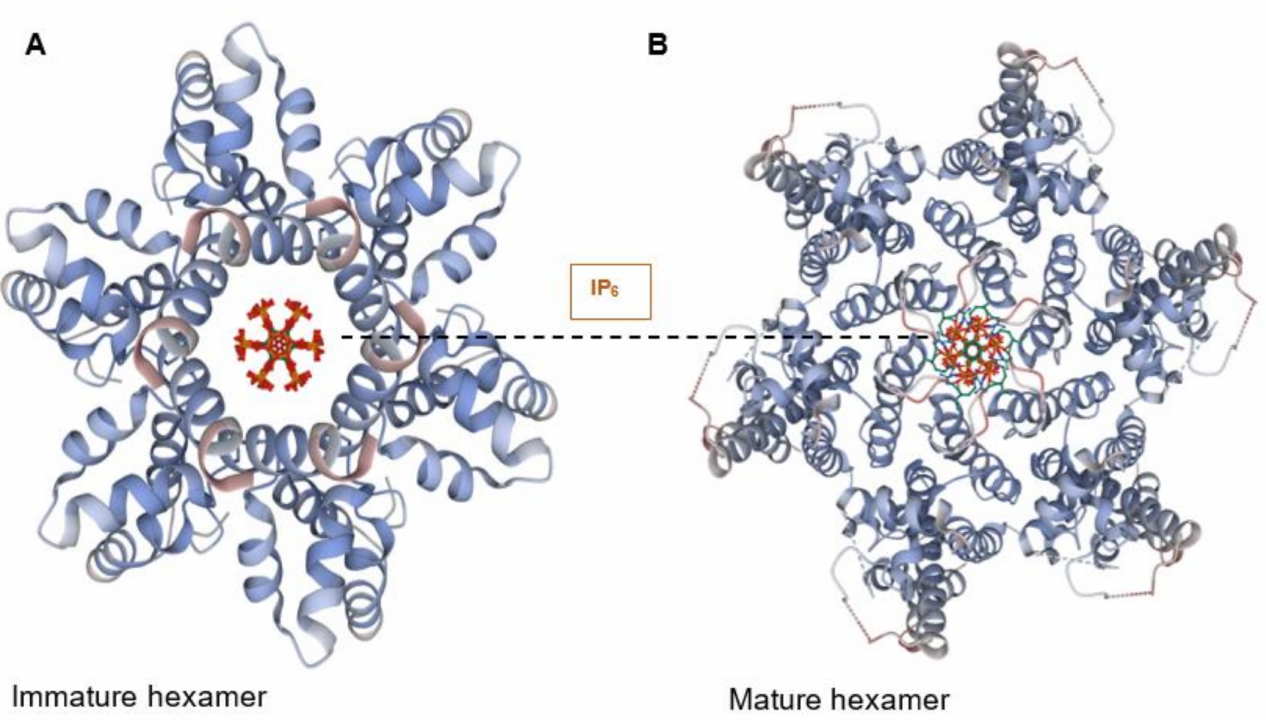
Figure 2. IP 6 binds to CA hexamers. ( A ) IP 6 bound to the central channel of the immature capsid hexamer (PDB 6BHR) [29]. ( B ) IP 6 bound to the Arg18 ring in the central channel of the mature CA hexamer (PDB 6ES8)